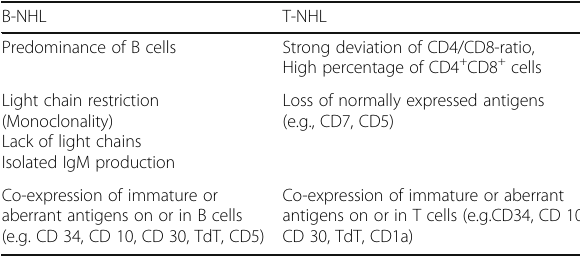
Table 20 Immunological recognition of lymphoma cells in CSF